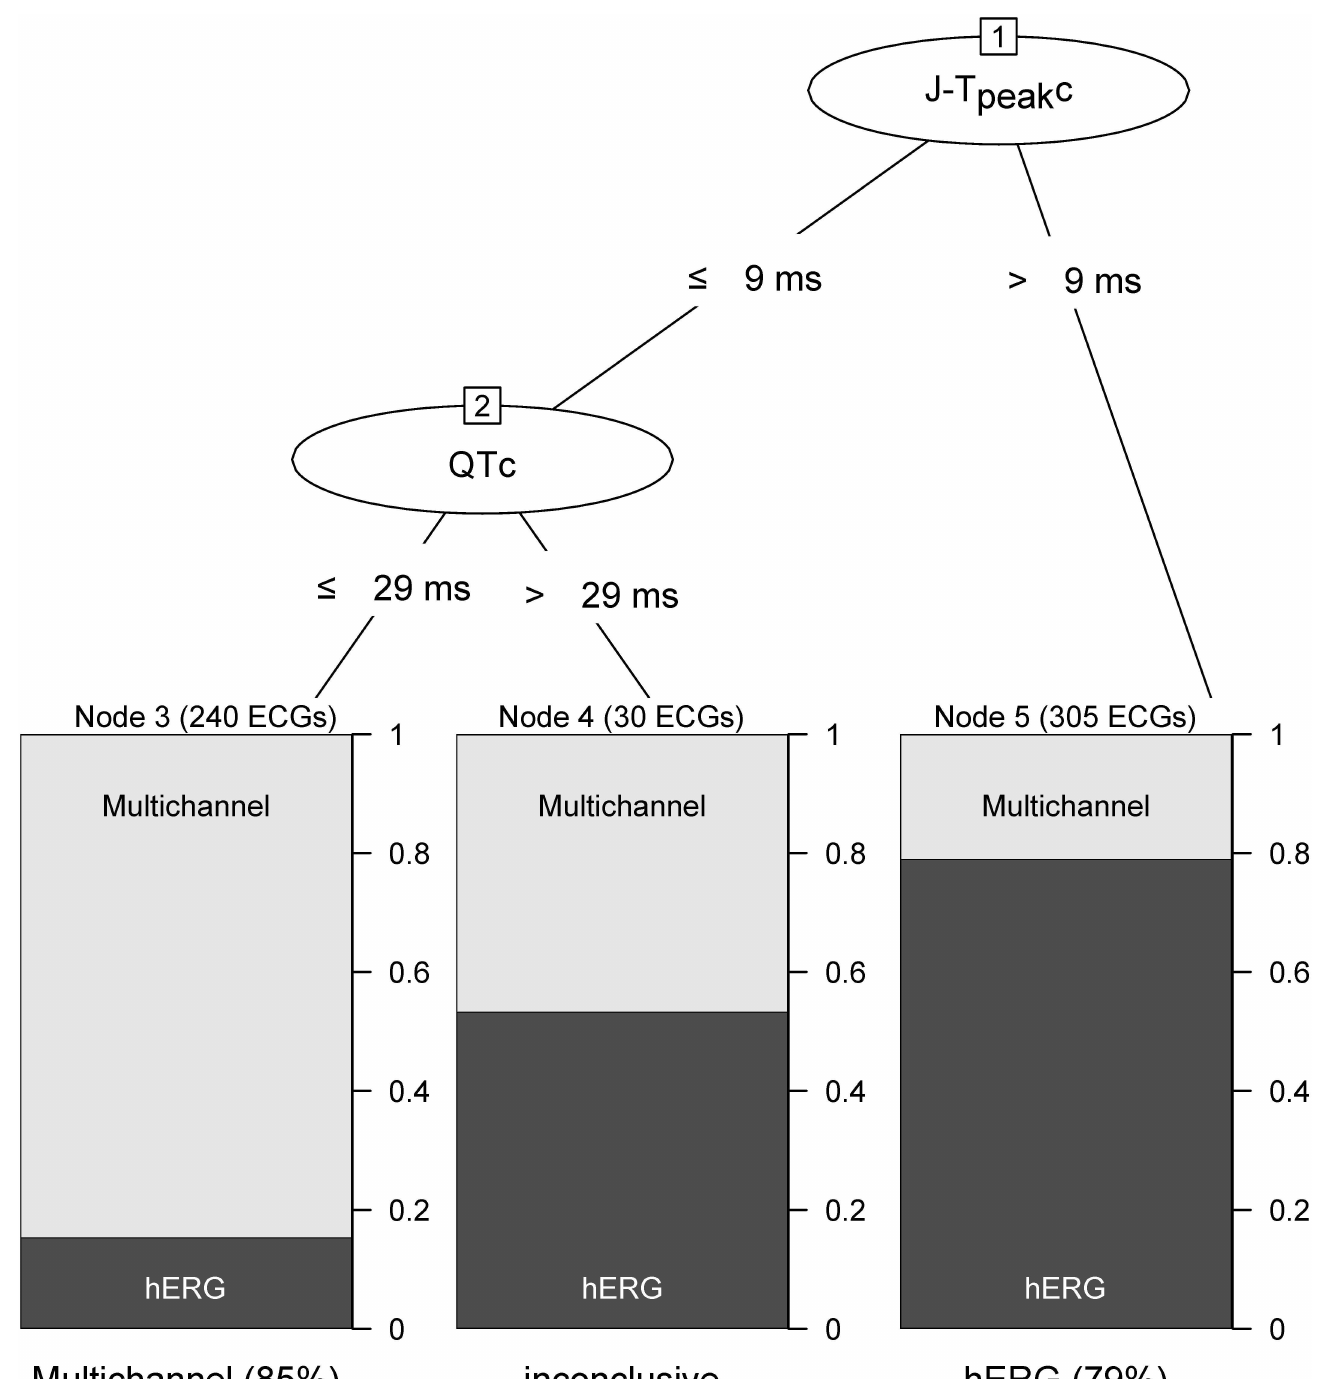
Fig 5. Decision tree. The decisiontree classifies the drug effects on any ECG from any time point based on the time-matched placebo-corrected changes from baseline( ΔΔ ) as selective of predominant hERG potassium channel block (right bin), multichannel block (left bin) or inconclusive (middlebin). More specifically, if ΔΔ J-T peak c is greater than 9ms the ECG is classified as predominant or selective hERG potassium channel block. If ΔΔ J-T peak c is less than or equal to 9ms and ΔΔ QTc less than or equal to 29ms, then the ECG is classified as multichannel block. Otherwise the classification is inconclusive. The number of ECGs from each class in the training set is reported in parenthesis on top of each class bin. The percentage of ECGs correctly classified within each class is reported below each class bin. See text for more details on classification performancein both training (hERG [dofetilide and moxifloxacin] vs. multichannel [dofetilide + mexiletine and dofetilide+ lidocaine])and validation(hERG [dofetilide